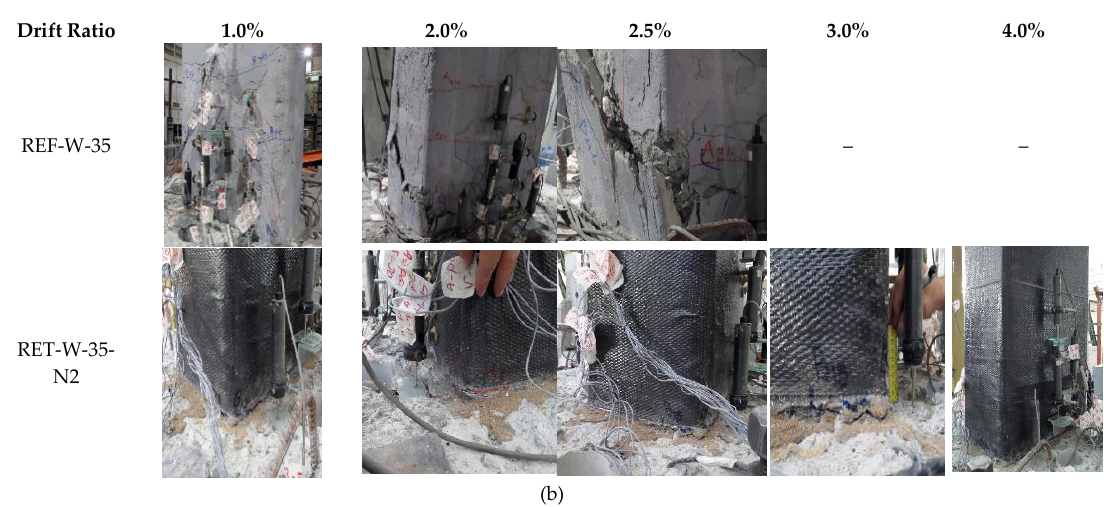
Figure 5. ( a ) Damage evolution of the R35 series; ( b ) damage evolution of the RW35 series.